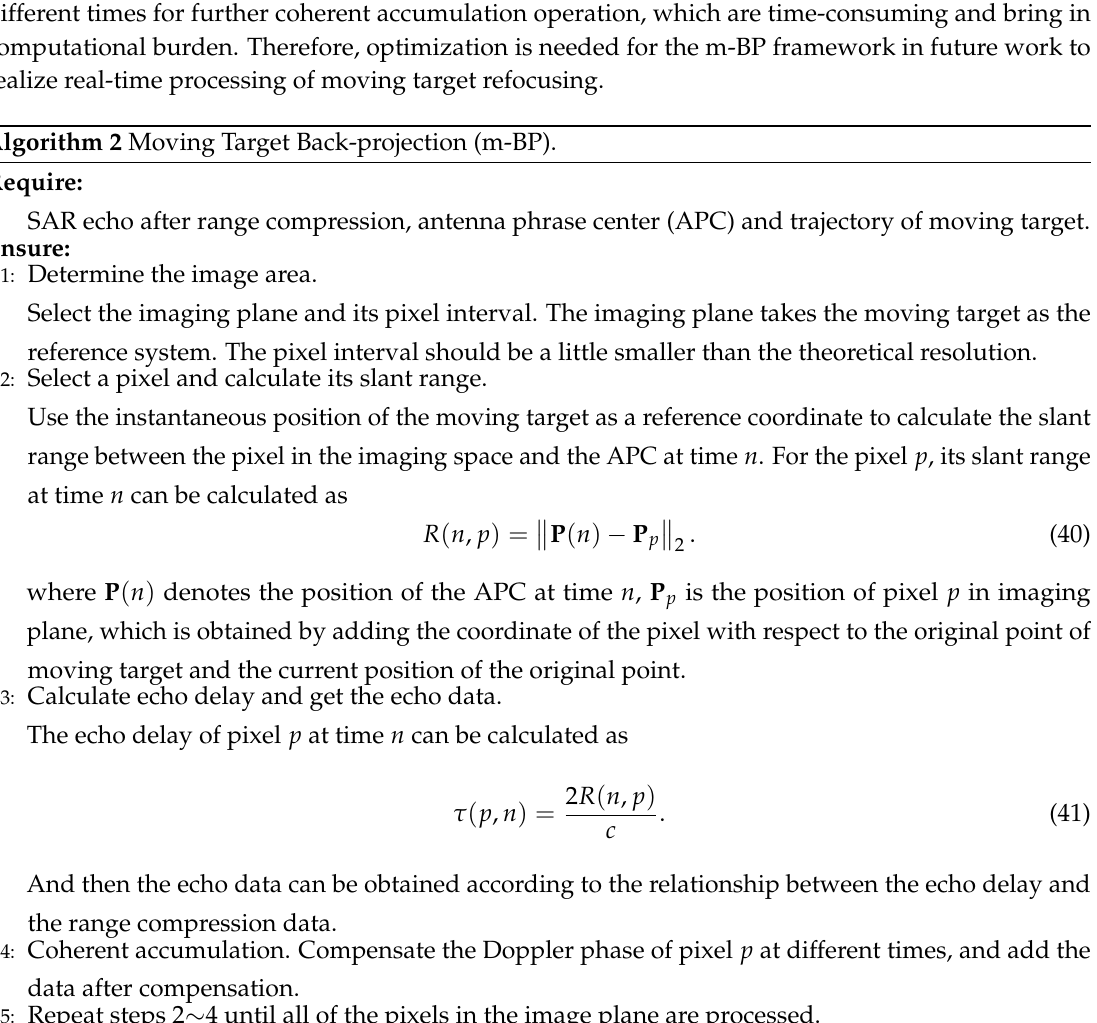
Algorithm 2 Moving Target Back-projection